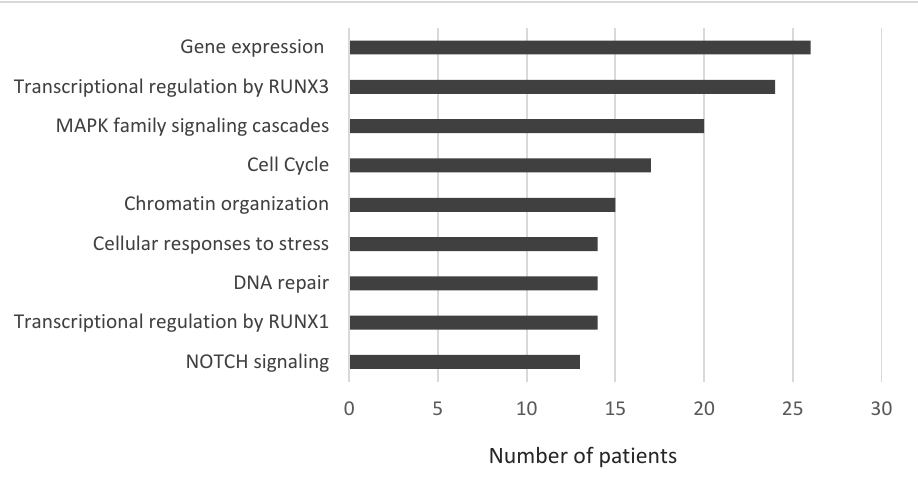
Figure 2. The proportions of multiple myeloma patients bearing mutations in genes involved in a particular cellular process.